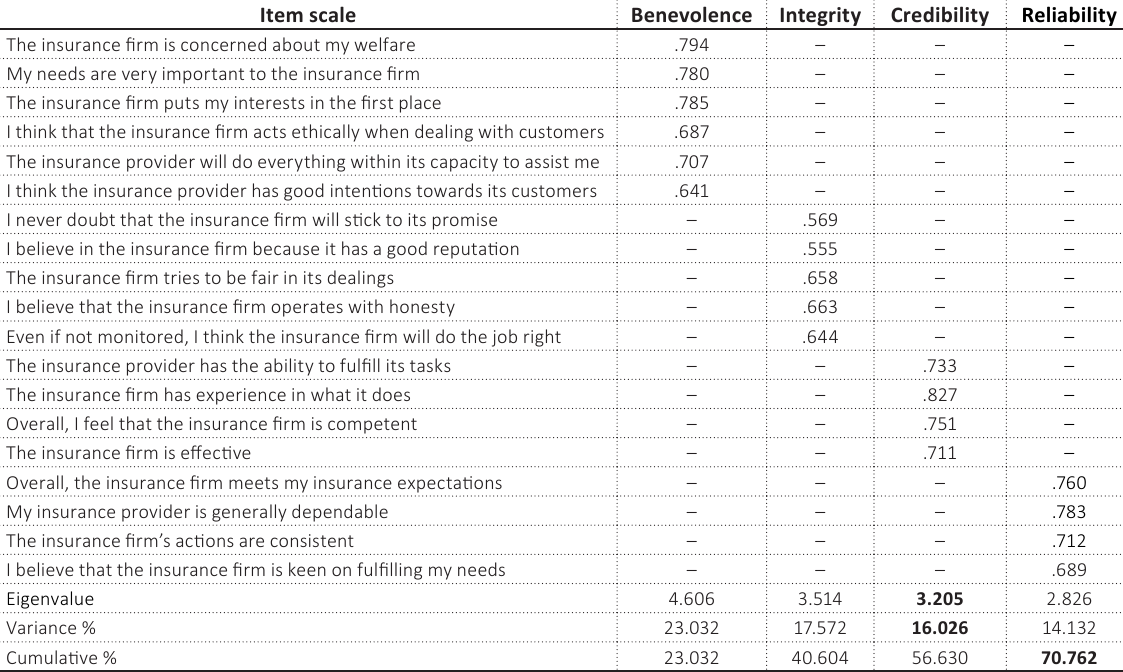
Table 1. Exploratory factor analysis for perceived trust Item scale